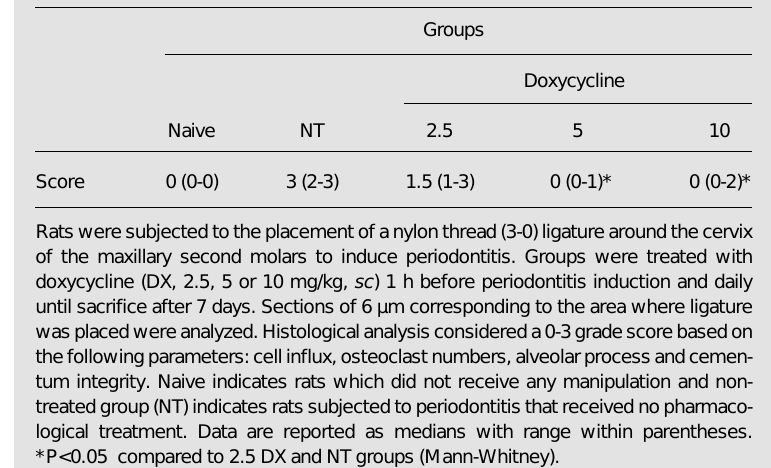
Figure 1. Effect of doxycycline (DX) treatment on alveolar bone loss (ABL) in periodontitis. Rats were subjected to the place- ment of a nylon thread (3-0) liga- ture around the cervix of the maxillary second molars. Rats were treated with DX (2.5, 5 or 10 mg/kg, sc ) 1 h before peri- odontitis induction and daily un- til sacrifice after 7 days. ABL was measured (mm) under micros- copy (4X original) as the distance between the cemento-enamel junction and the alveolar bone. “C” indicates naive animals. Data are reported as means ± SEM for six animals in each group. *P<0.05 compared to nontreated (NT) rats (ANOVA).